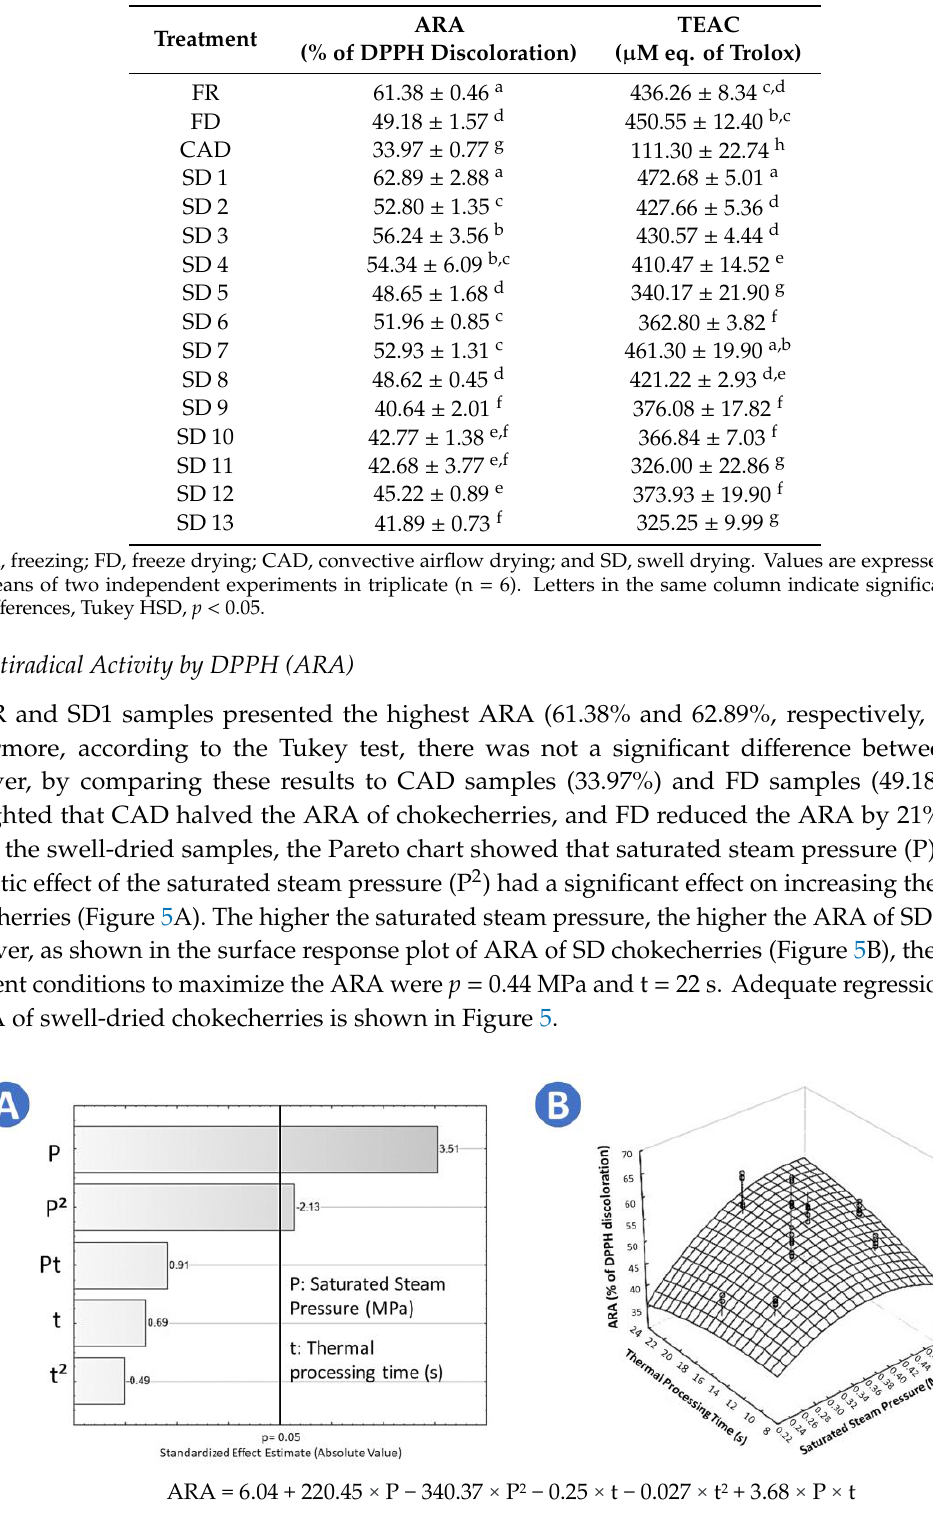
Figure 5. Effects of steam pressure (MPa) and thermal processing time (s) on the antiradical activity by DPPH of swell-dried chokecherries. ( A ) Pareto chart and ( B ) surface response plot.